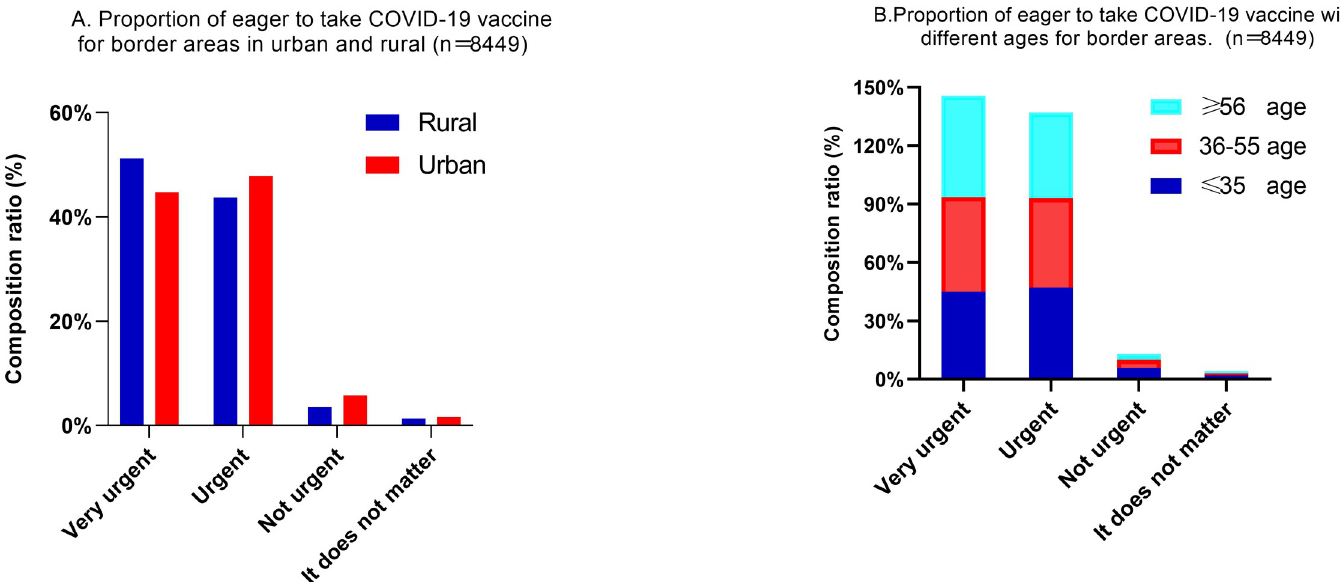
Factors influencing willingness to vaccinate against COVID-19 The results of the survey reveal that 27.9% (2473/8849) of the respondents believed that new cases of COVID-19 would significantly affect their willingness to get vaccinated against COVID-19, while the remaining 39.9% (3527/8849) of the respondents believed that new cases would not affect their willingness.